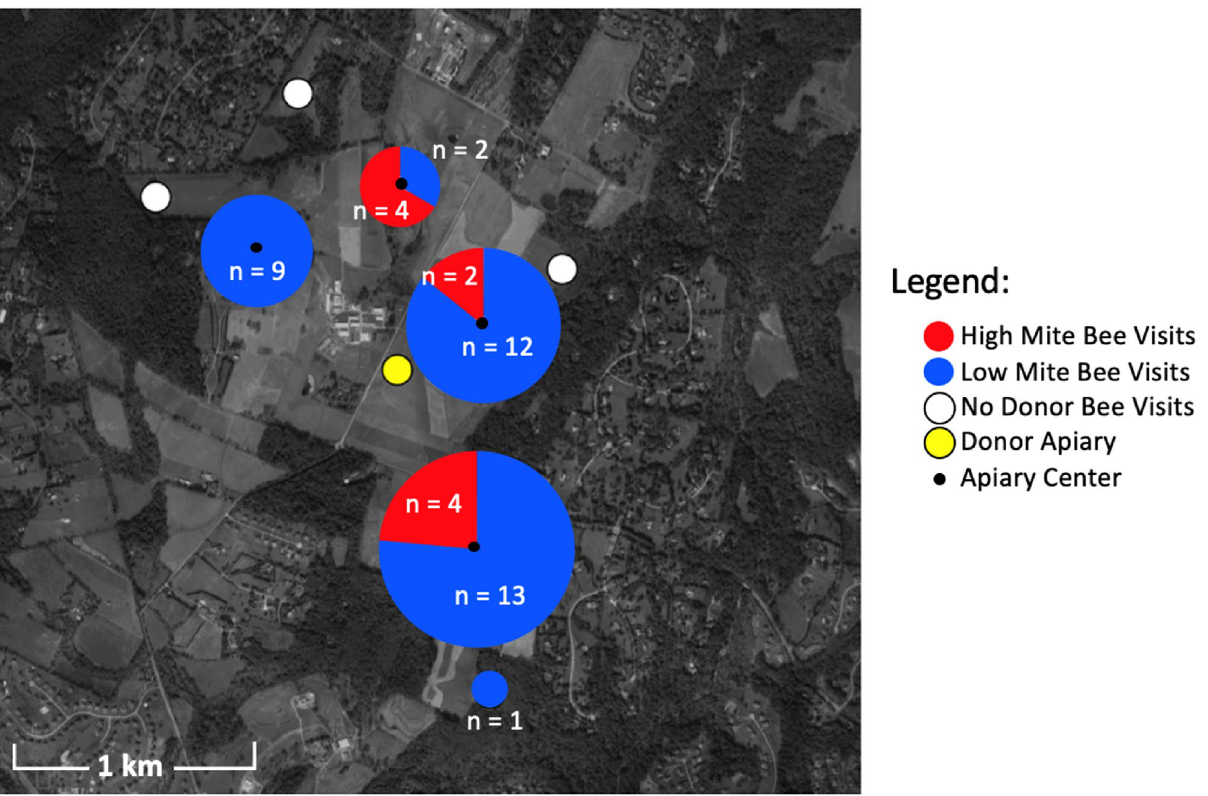
Figure 9. Location, number, and color of painted bee detections. Pie charts represent the number of high and low mite bees detected in each receiver apiary. Black dots represent the geographic center of each apiary. White circles are receiver apiaries where no painted bees were found, the yellow circle indicates the donor apiary. Map produced with R version 3.3.3 (https:// www.r- proje ct.